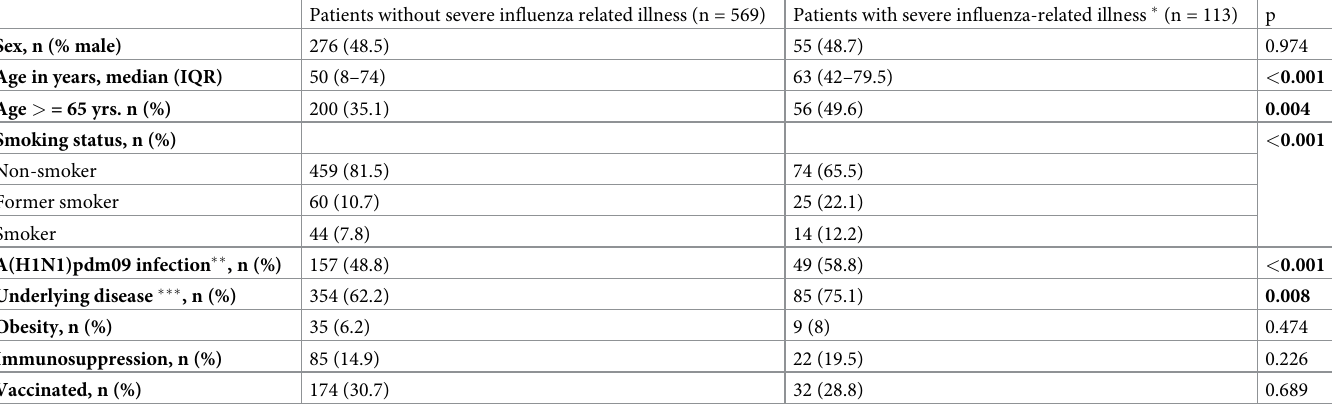
Table 3. Univariate analysis of factors associated with severe influenza-associated illness.